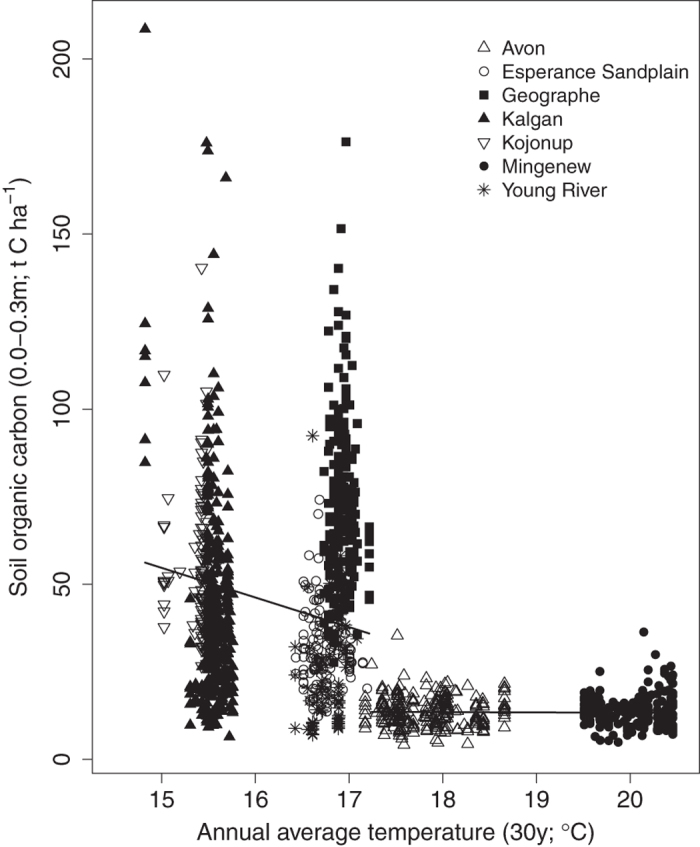
Total soil organic carbon (t C ha−1; 0–0.3 m) in Western Australia (n = 1348 sample points) against average annual daily temperature (°C) based on 30 year history.Symbols represent different regions as depicted in the legend. The solid line represents the change point regression analysis (see Table 2).